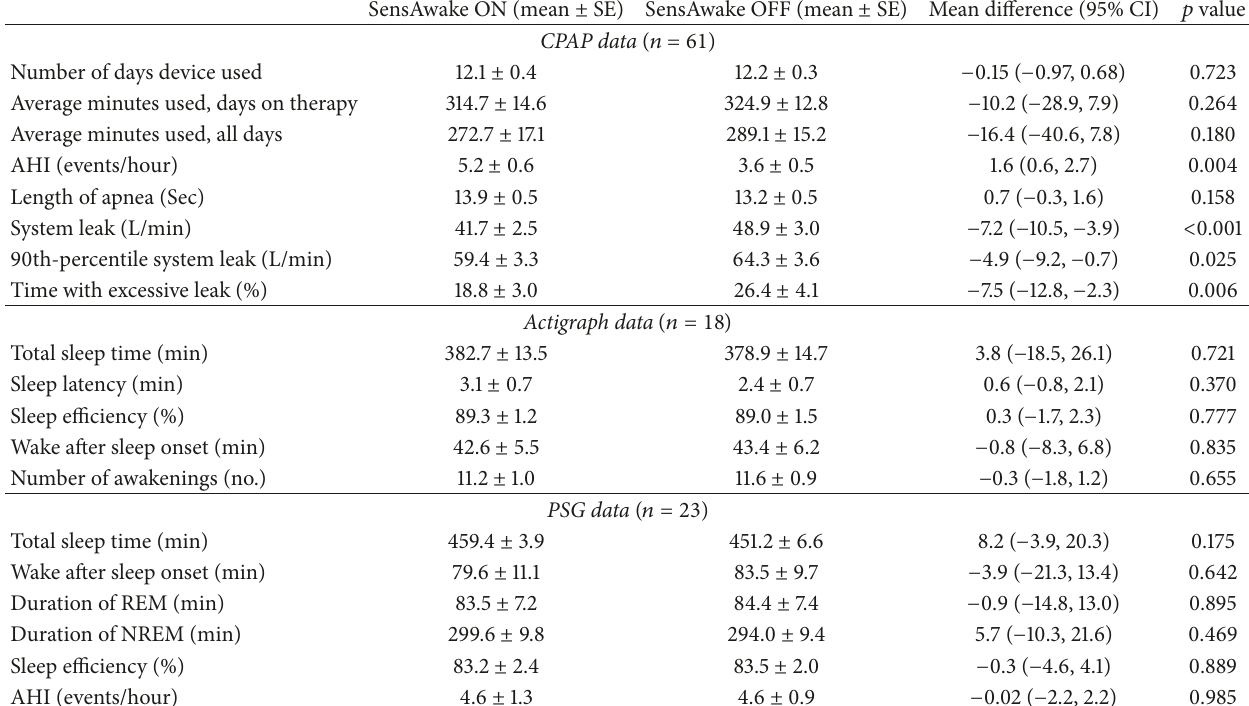
Table 1: Objective sleep quality in CPAP devices with and without